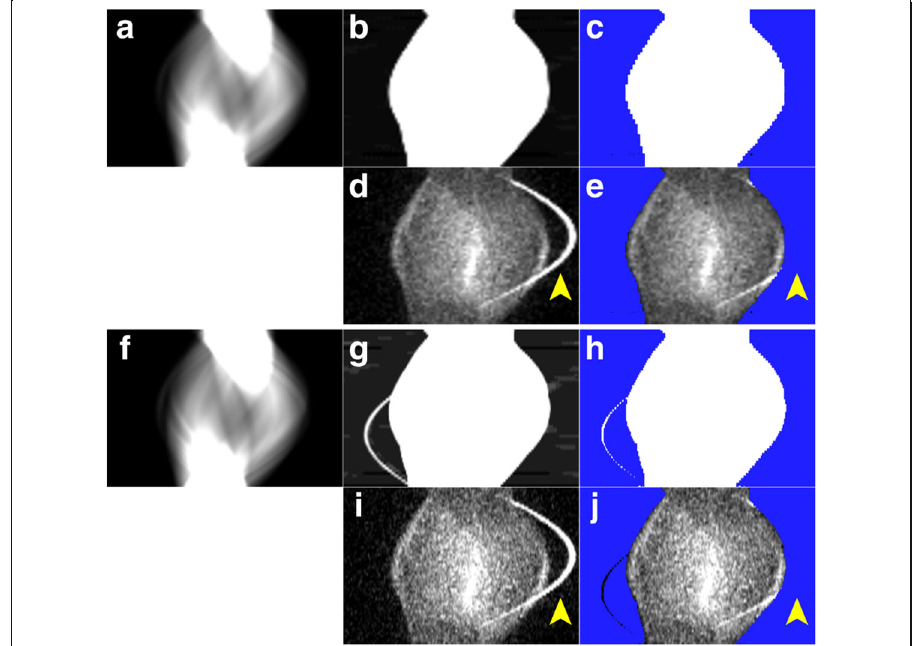
Fig. 4 Sinogram images on 4-mm ( a – e ) and 2-mm ( f – j ) voxel size (urine shift pattern). μ -map sinogram ( a , f ), changing display scaling of a , f ( b , g ), mask for TF-SSS algorithm ( c , h in blue ), random-corrected emission ( d , i ), and mask superimposed on the emission sinogram ( e , j ). Both 4-mm and 2-mm voxel size μ - map sinograms masked the urinary catheters ( yellow arrows